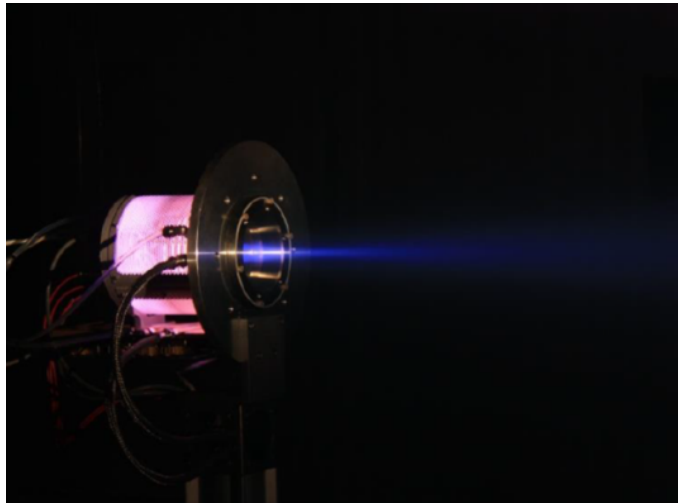
Figure 5: RIT10/37 thruster in operation in the